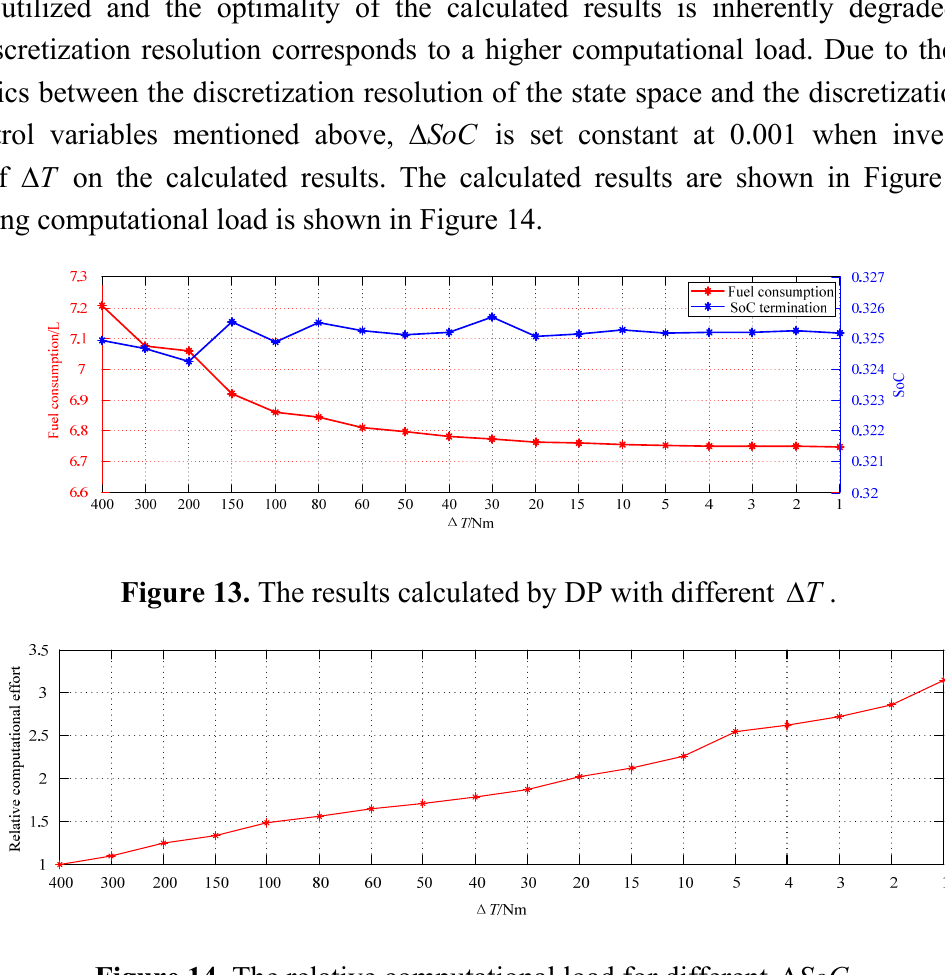
Figure 14. The relative computational load for different SoC 